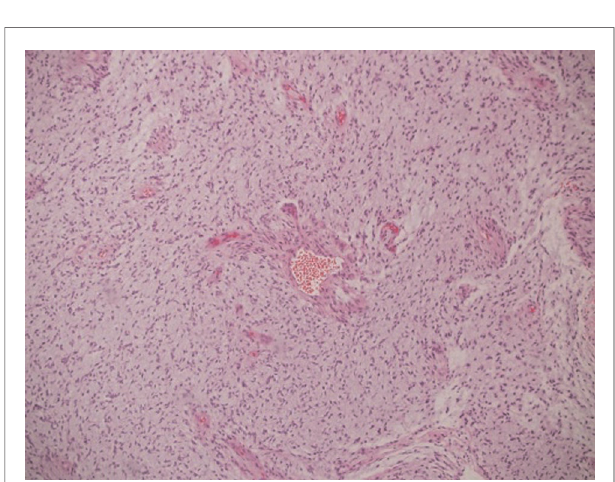
FIGURE 3 | Histopathology examination showed astrocytoma with myxoid features suggestive of pilomyxoid astrocytoma with a background of hemorrhagic